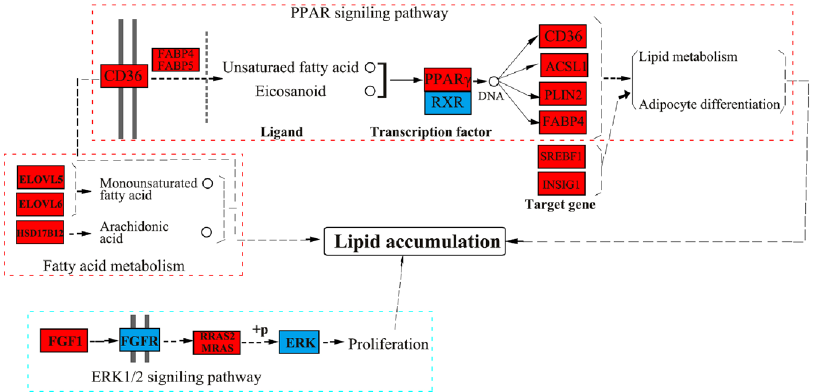
Figure 6. The regulatory network of lipid accumulation with significant characteristics in Wagyu cattle. The regulatory network comprised PPAR signaling pathway, fatty acid metabolism and MAPK signaling pathway in which PPAR signaling pathway and fatty acid metabolism were significant enrichment. The red oblongs represent the up-regulated genes in subcutaneous fat of Wagyu cattle. The blue oblongs represent the undifferentiated genes. SREBF1 and INSIG1 were reported as the target genes of PPAR γ in previous researches. The critical part of those pathways and key genes involved were showed in the regulatory network. Those pathways drawn is mainly referred to the KEGG database (www.kegg.jp/kegg/pathway.html) 71–73